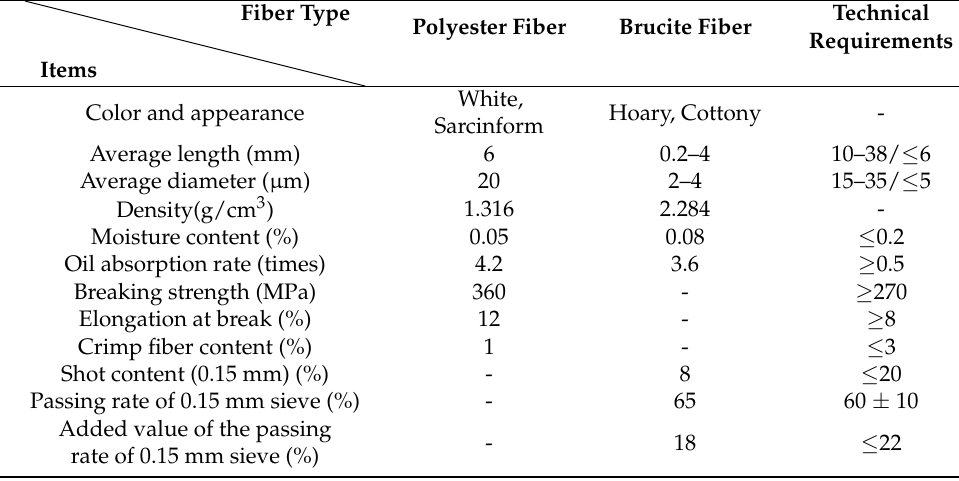
Table 2. Basic technical characteristics and requirements of the two